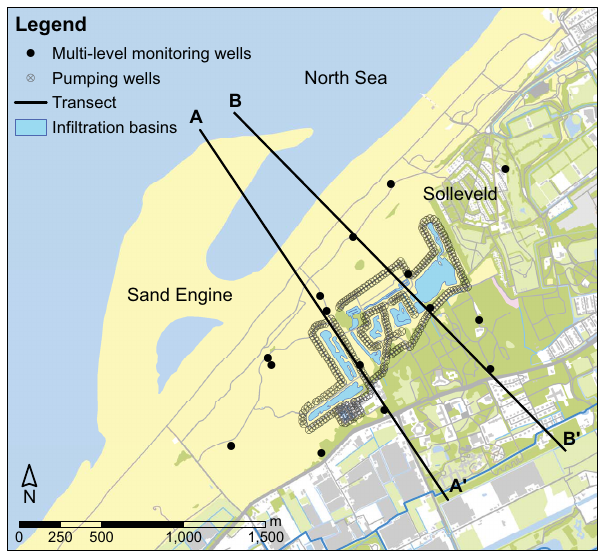
Figure 2. Map of the dune area Solleveld with multi-level monitor- ing wells and pumping wells, including transects A and B (geolog- ical profiles in Fig.